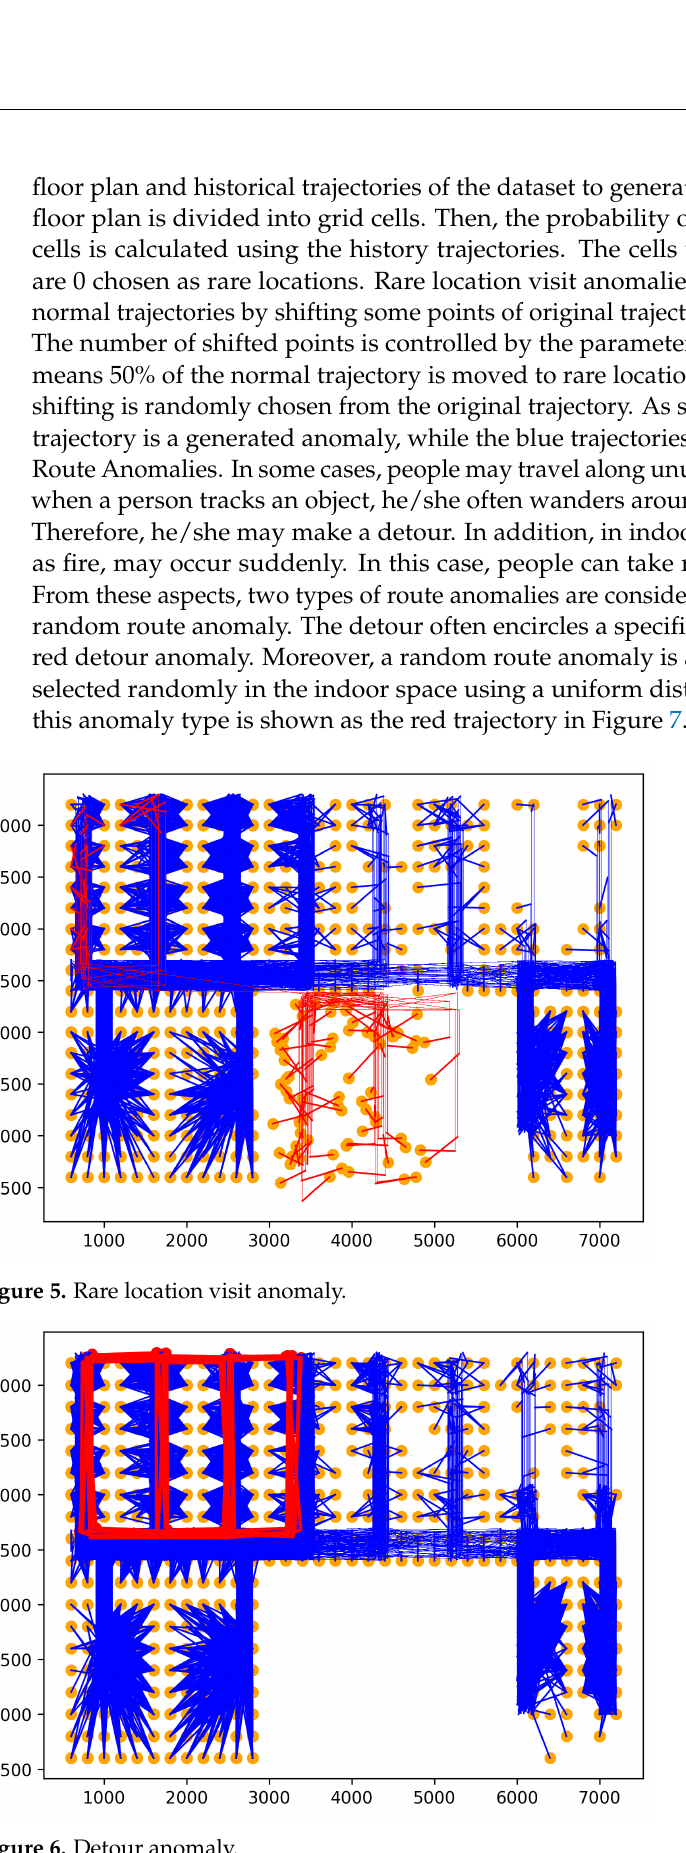
Figure 6. Detour